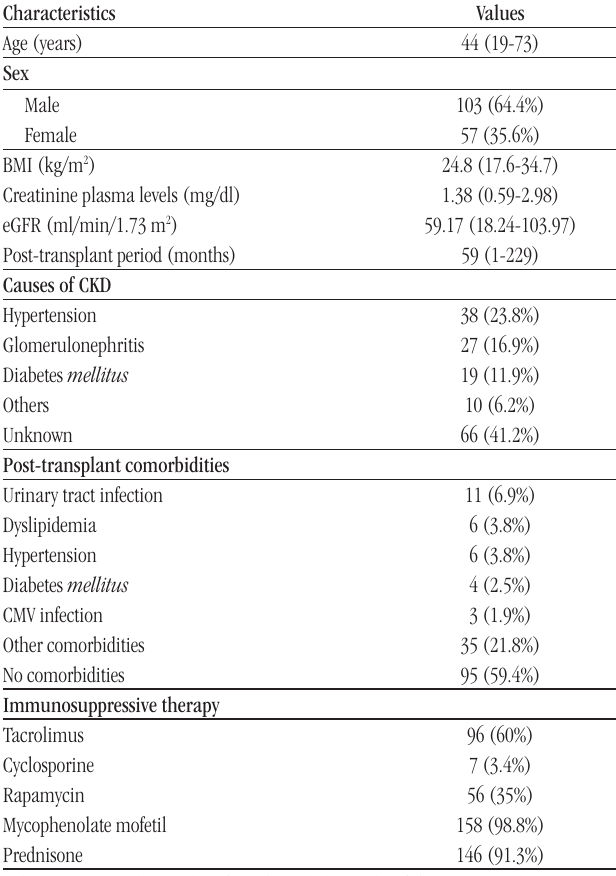
taBLE 1 − Clinical characteristics of renal transplant recipients